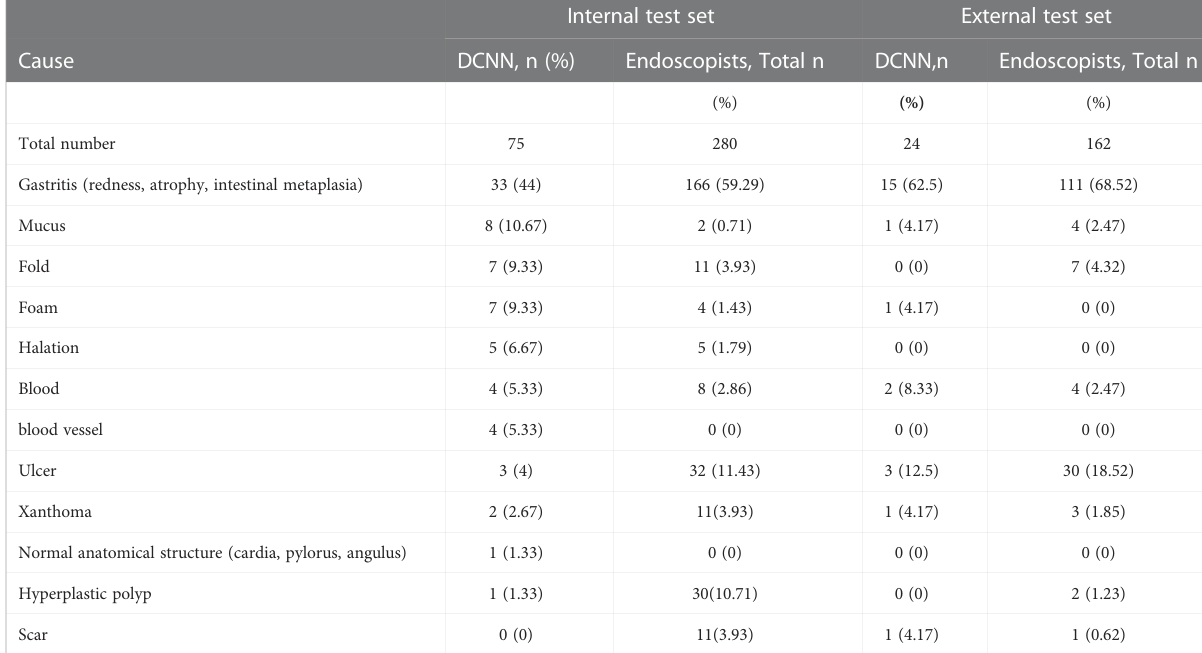
TABLE 3 Details of DCNN model and false positive images of